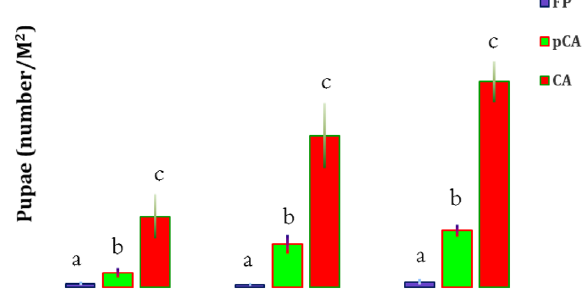
Figure 4. Mean number of pupae of Mythimna separata in the fields with different tillage-cum-crop establishment and residue management production systems after harvesting wheat in recent years. Bars with different letters indicate significant differences among production systems (LSD; P < 0.05).